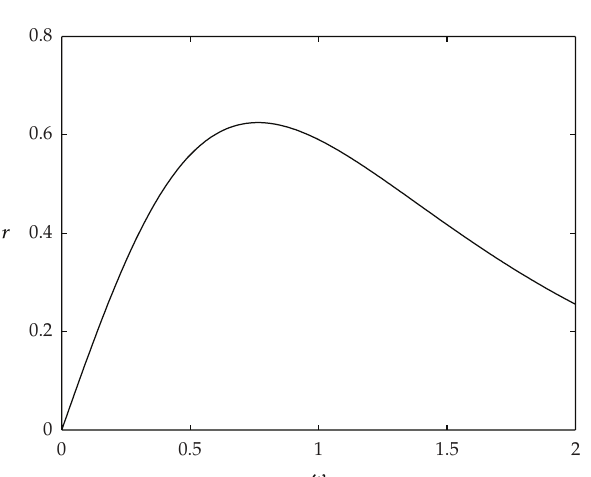
Figure 2: Homoclinic bifurcation curve for Smale horseshoe chaos in the (cid:6) ω,r (cid:7) plane for δ (cid:8) 0 . 5, A (cid:8) 1, and B (cid:8) 1. Above the curve transverse intersections of homoclinic orbits